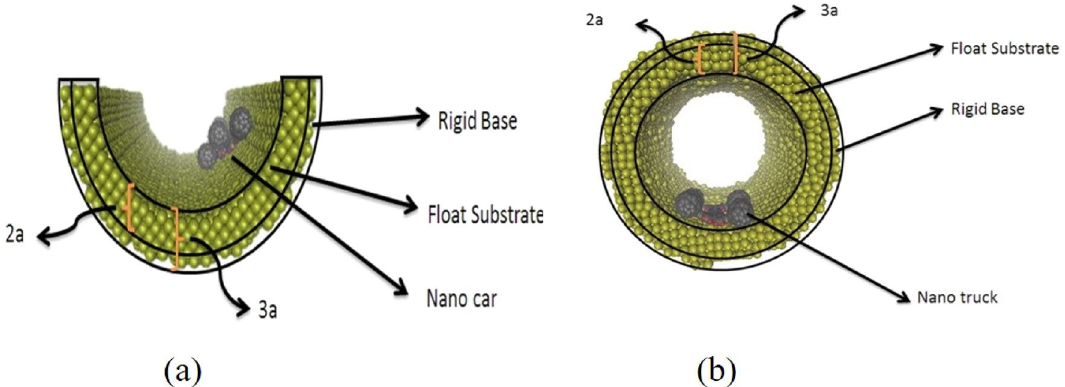
Figure 1. Description of simulation samples. ( a ) nanocar on the concave substrate and ( b ) nanotruck on the cylindrical